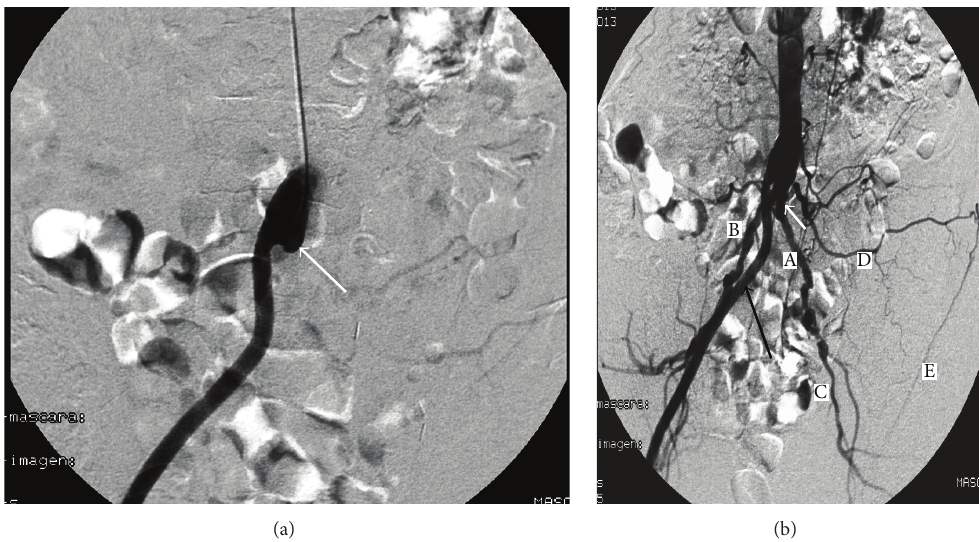
Figure 1: (a) Early image of abdominal angiogram showing a complete occlusion of the left arm of the ABFB (arrow). (b) The right arm of the ABFB is patent (black arrow); proximal button of the left ABFB (white arrow); primitive iliac arteries (A, B); collateral circulation: left hypogastric (C), left lumbar (D), and circumflex iliac (E) arteries.